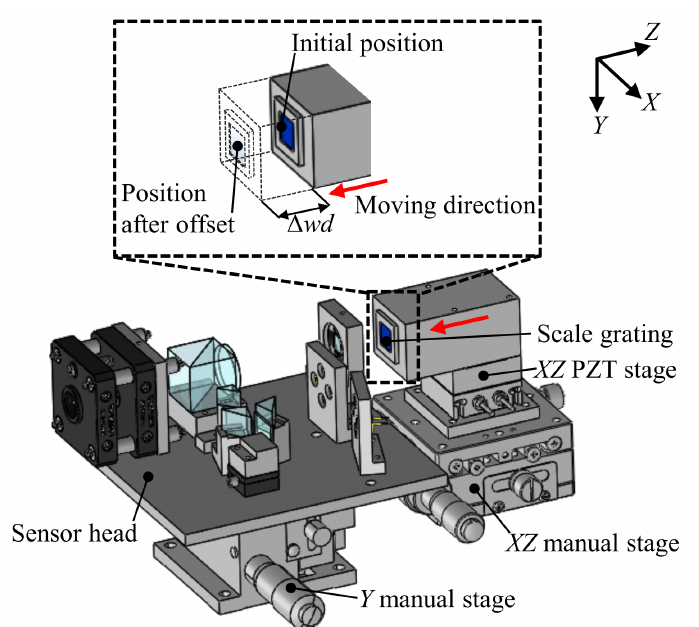
Figure 10. Schematic of the experimental setup for testing the Z -axis measuring range of the sur- face